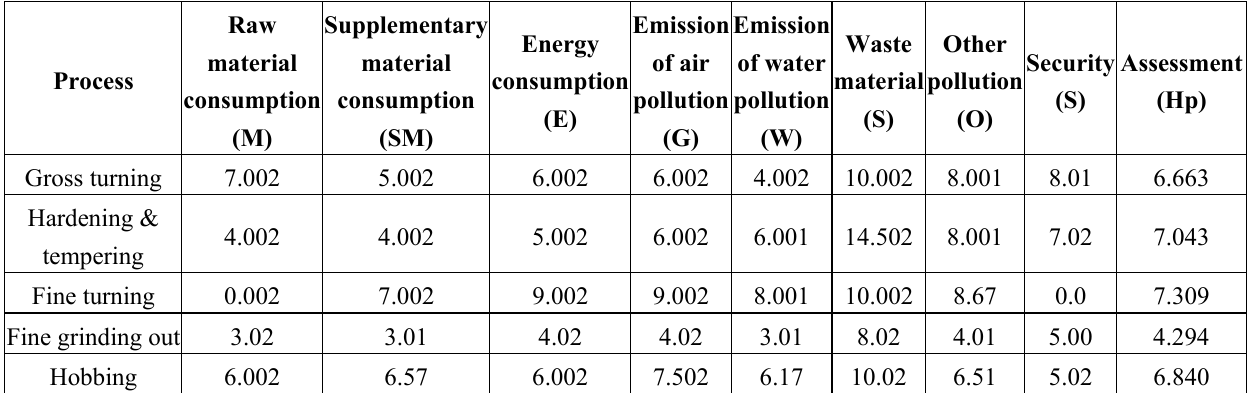
Table 4. Integrated EBM values of the case